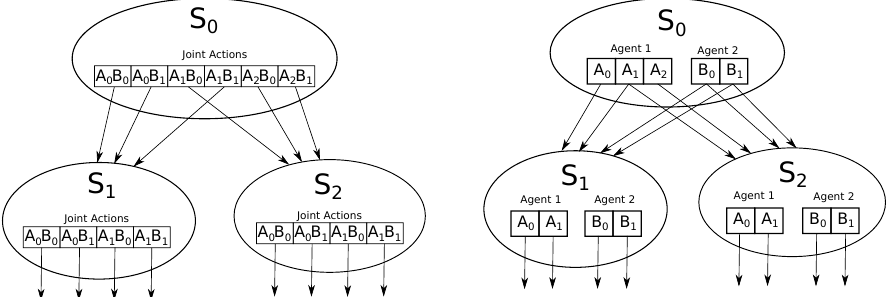
Figure 2. On the left, the search tree of UCT with the joint actions. On the right, the search tree of decoupled-MCTS with nodes having different set of actions for each agent